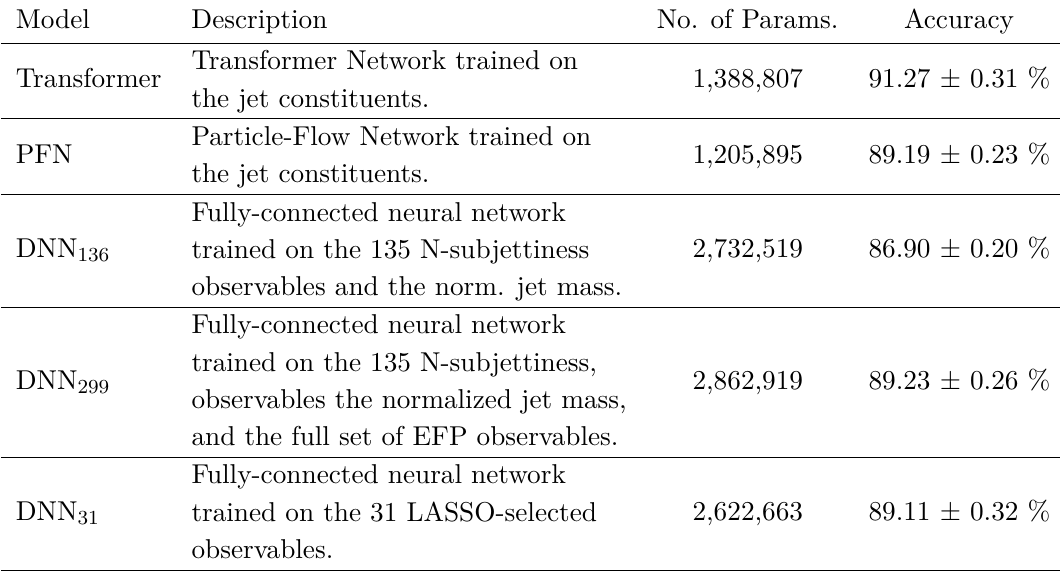
Table 4 . Summary of the machine learning models used in the classification task. The table shows a brief description of each of the models, as well as the number of trainable parameters and the accuracy measured using 10-fold cross